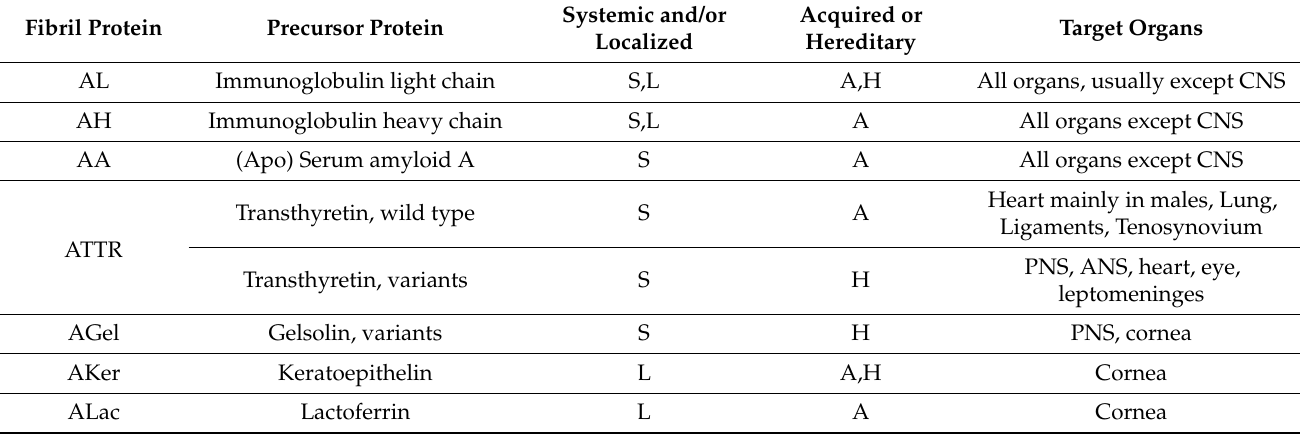
Table 1. Amyloid fibril proteins and their precursors involved in eye